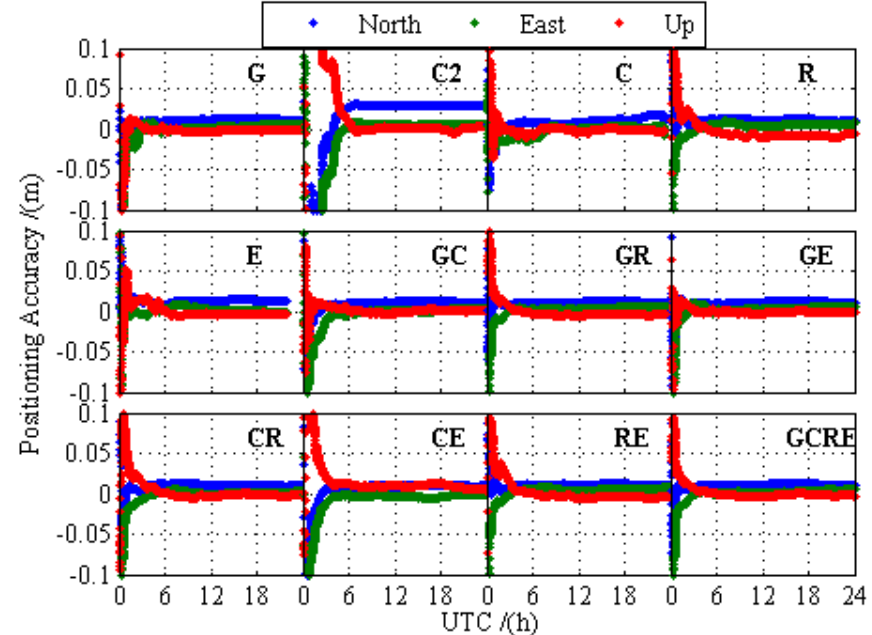
Figure 3. Static PPP positioning errors at BRCH for 12 different processing cases on DOY 024 in 2019.